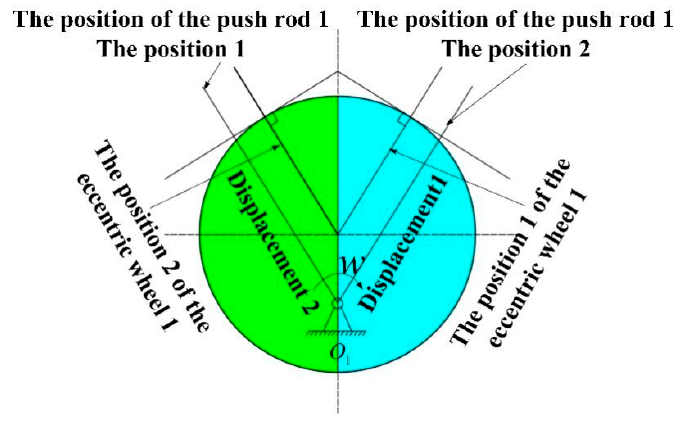
Figure 5. Push cam mechanism one.